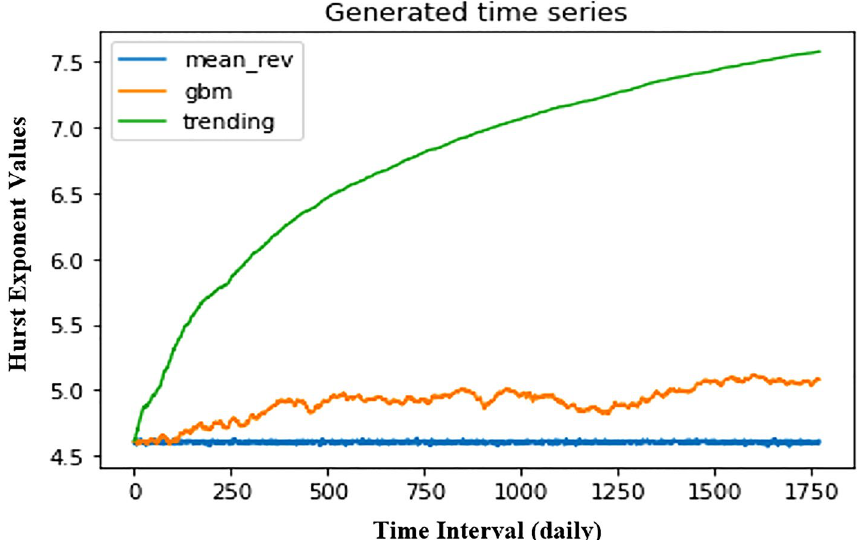
Fig. 5 A graph of generated time series for Hurst exponent with 1772 records of